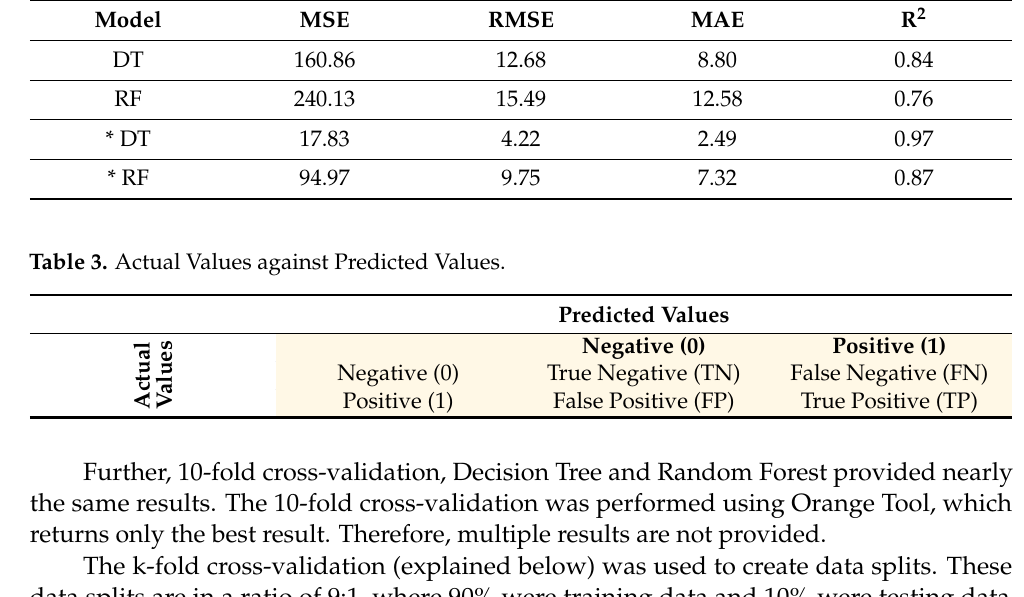
Table 2. Regression on Cytotoxicity associated with Carcinoma and Normal* cell lines.